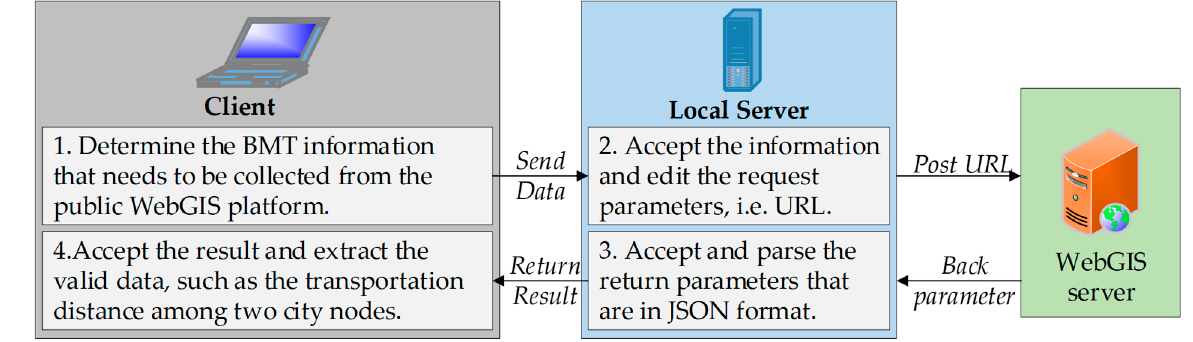
Figure 3. The technical process of web crawler technology based on WebGIS.